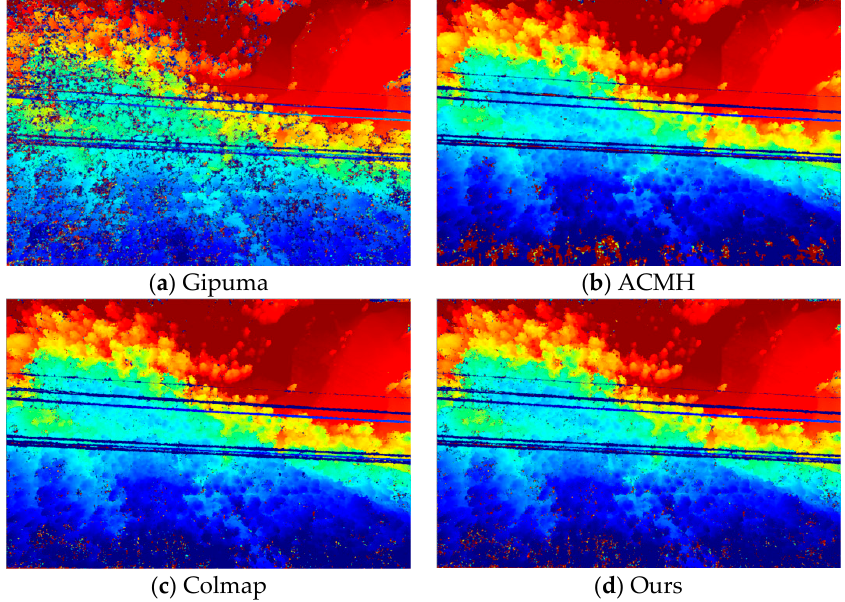
Figure 6. Depth maps comparison with different methods. ( a – d ) are generated by Gipuma, ACMH, Colmap, and the proposed method, respectively.